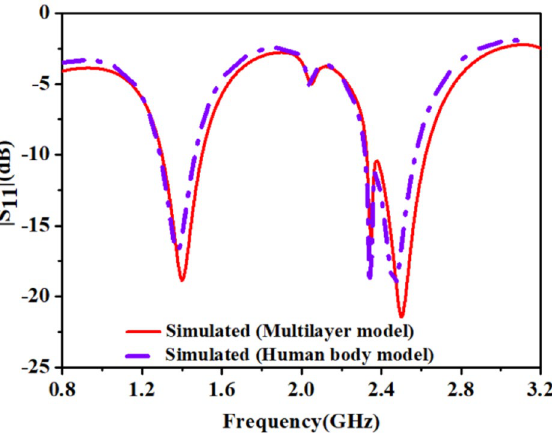
Figure 15. Comparison of simulated |S 11 | in multi-layer homogeneous model and heterogeneous human body model.